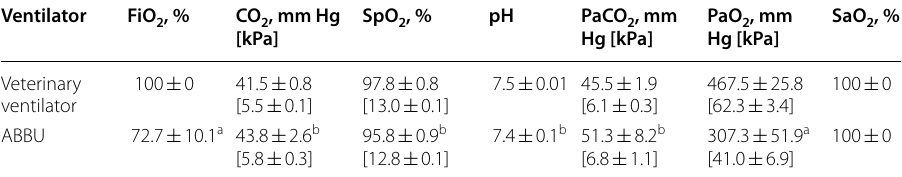
Summary of O 2 and CO 2 exchange with the veterinary ventilator and ABBU. Two‑tail T test was used for comparisons. All results are mean SE ± a p < 0.05 vs veterinary ventilator; b p > 0.05 vs veterinary